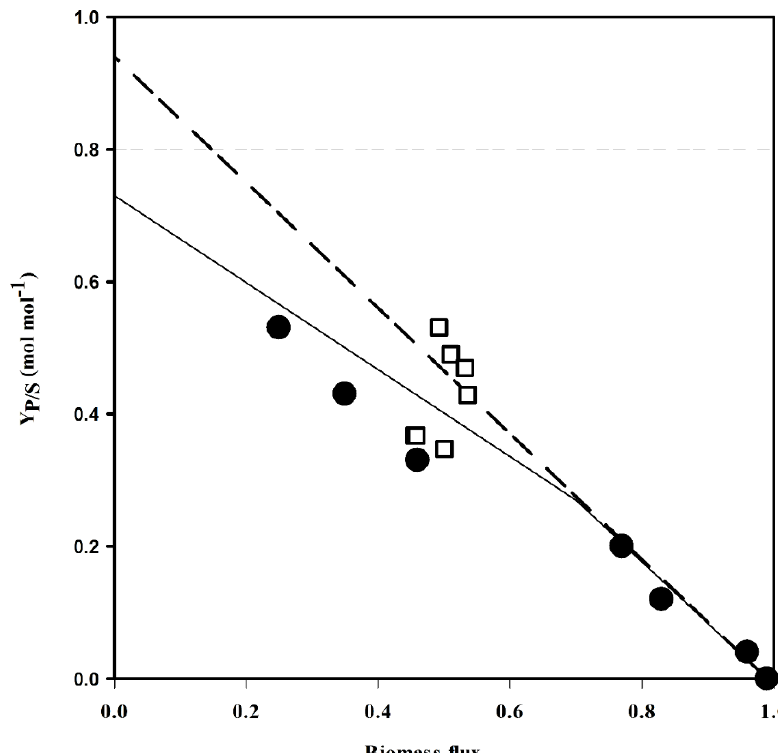
Figure 2. Comparison of theoretical and experimental putrescine yields. The putrescine flux response was analyzed by flux balance analysis with different biomass (the split ratio between Embden-Meyerhof-Parnas pathway (EMP) and pentose phosphate pathway (PPP) pathway was 6:4) when MalE was inactive (solid line) and active (dashed line). Circles: PUT3-27 [4], open squares: